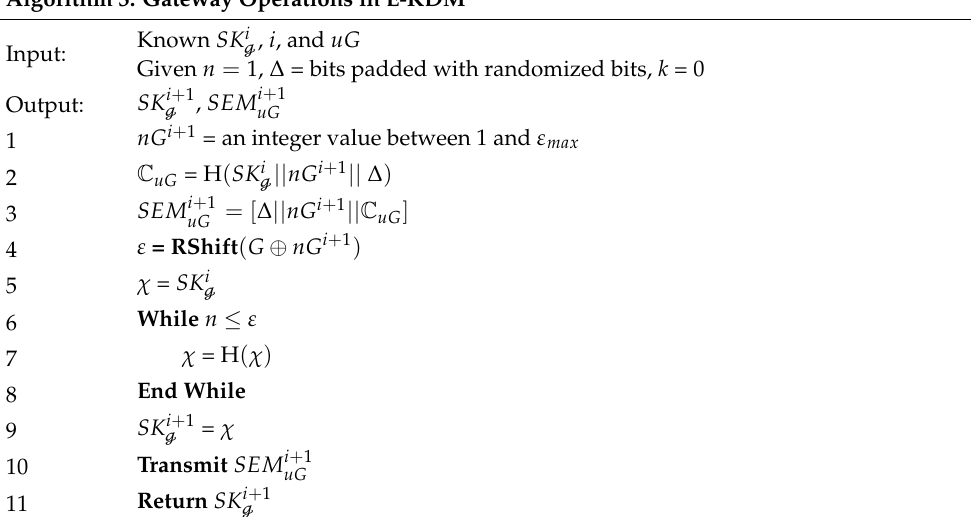
Algorithm 3: Gateway Operations in